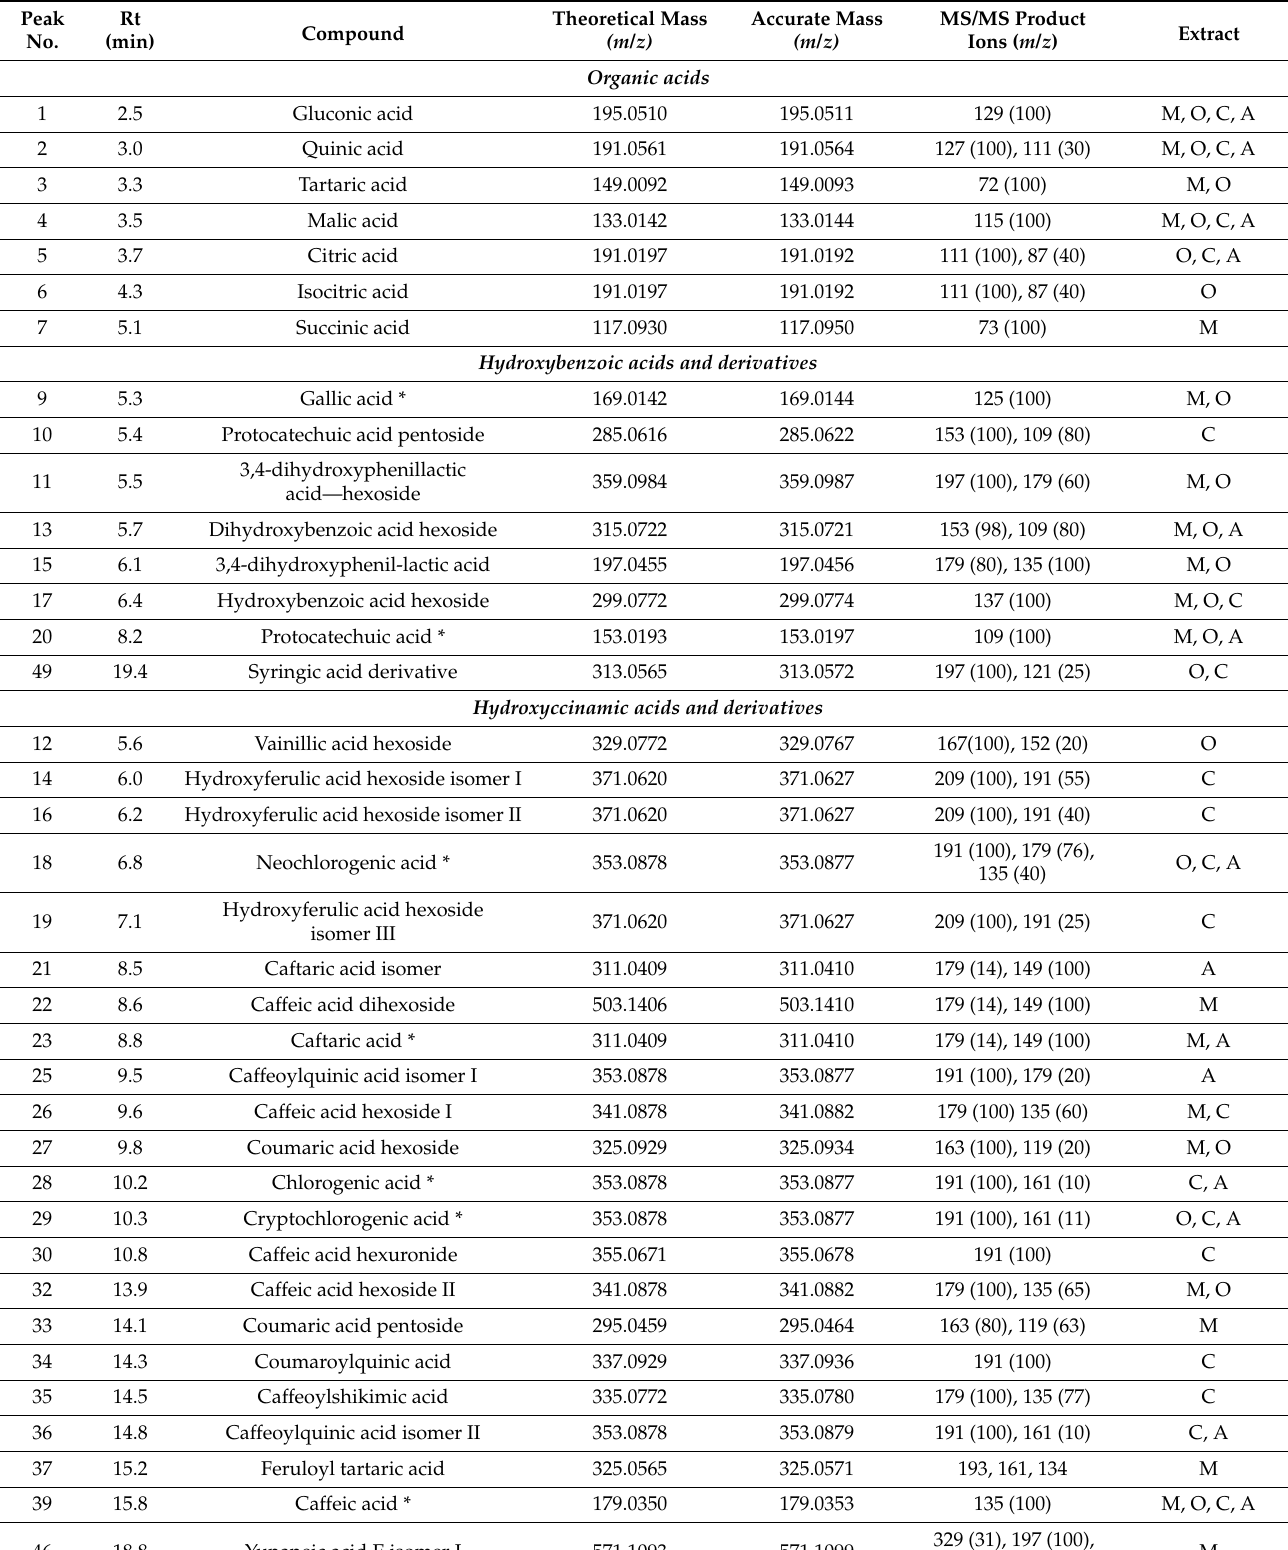
Table 2. Compounds identified by HPLC-PAD-ESI-QTOF-MS/MS (negative ionization mode) in the selected UAE 50% ethanol extracts from the Lamiaceae and Asteraceae genera. Peak